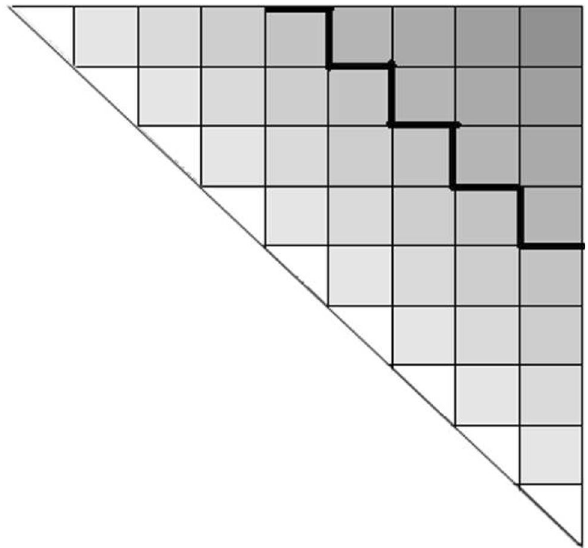
Fig. 4 Diagonal-after-diagonal evolution of calculation of the dynamic programming table corresponding to the OBST problem (from the clearest to the darkest